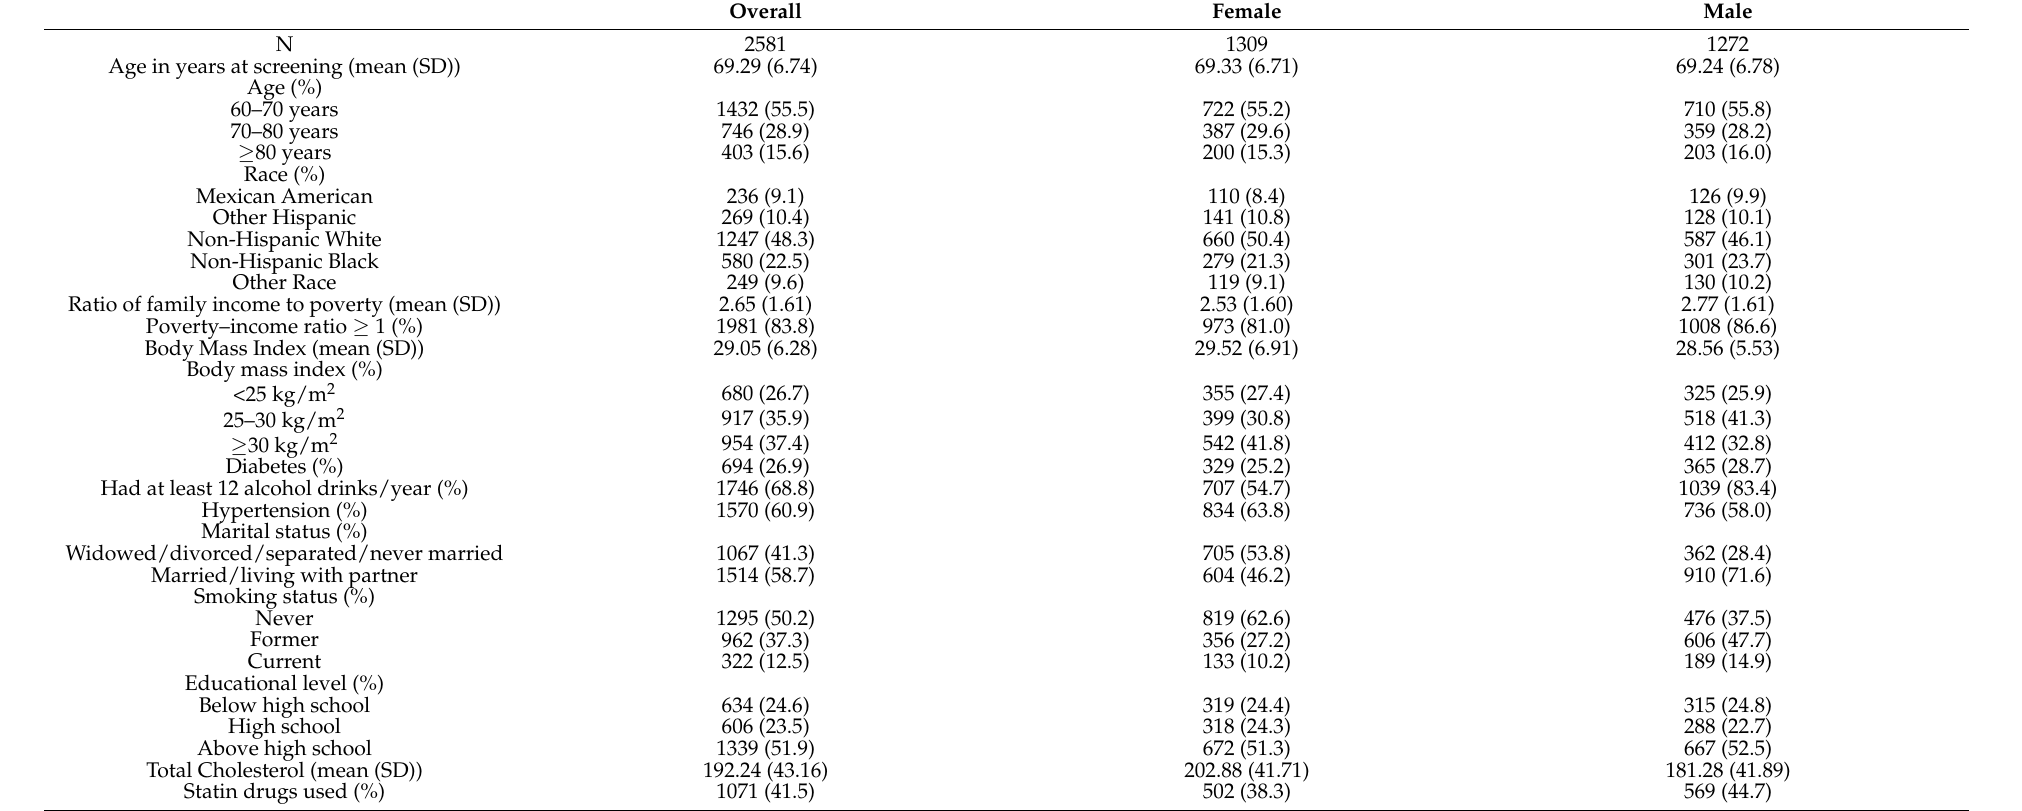
Data show number of subjects (percentage) or medians (interquartile